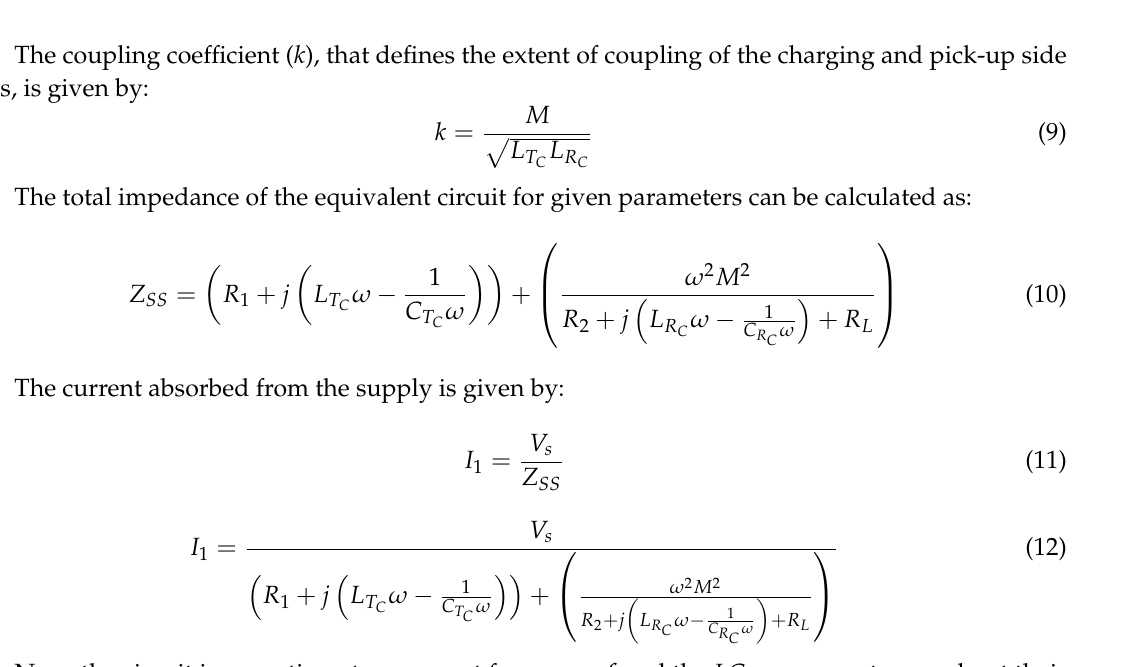
Figure 4. T-equivalent circuit of series-series Inductive Power Transfer (IPT) system.